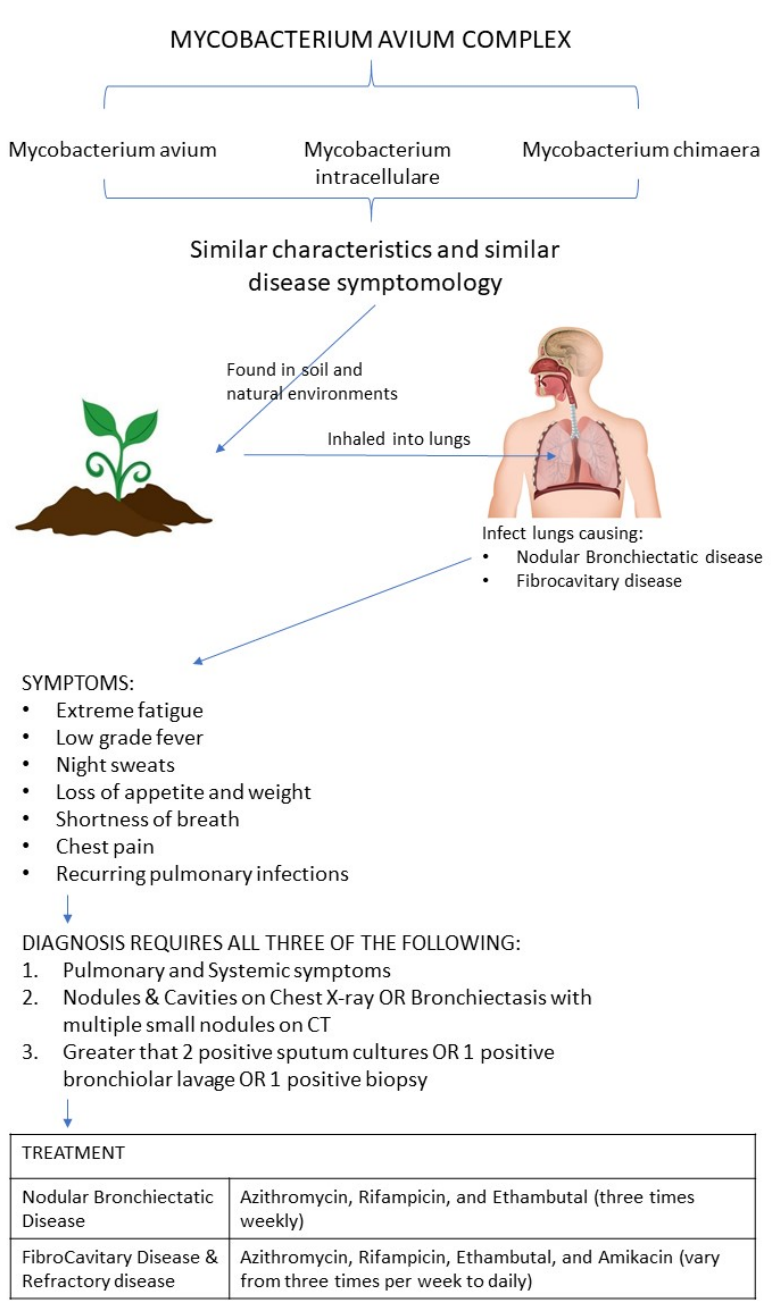
Figure 1. A figure elucidating the most common species making up MAC, MAC’s infectious route into the lungs, its symptoms, diagnosis, and treatment.